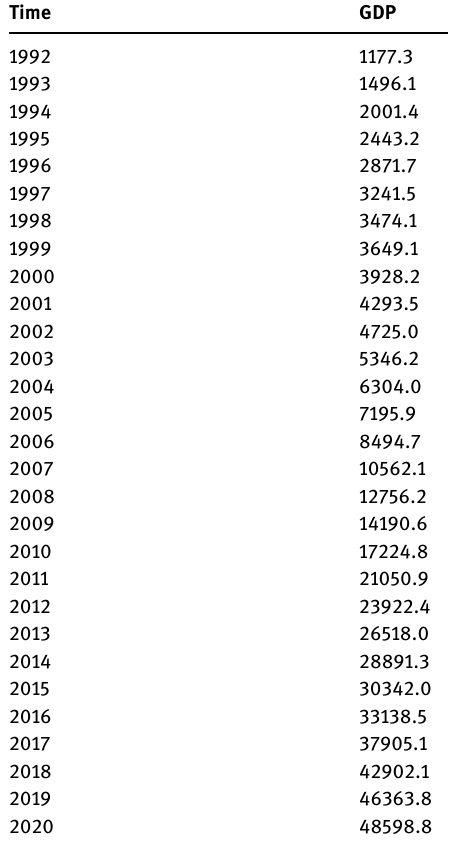
Table 1: GDP of Sichuan Province between 1992